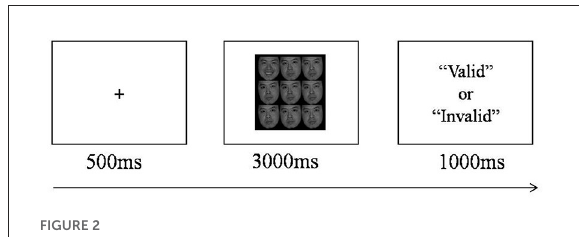
FIGURE2 The timelines of the emotional visual search task (single